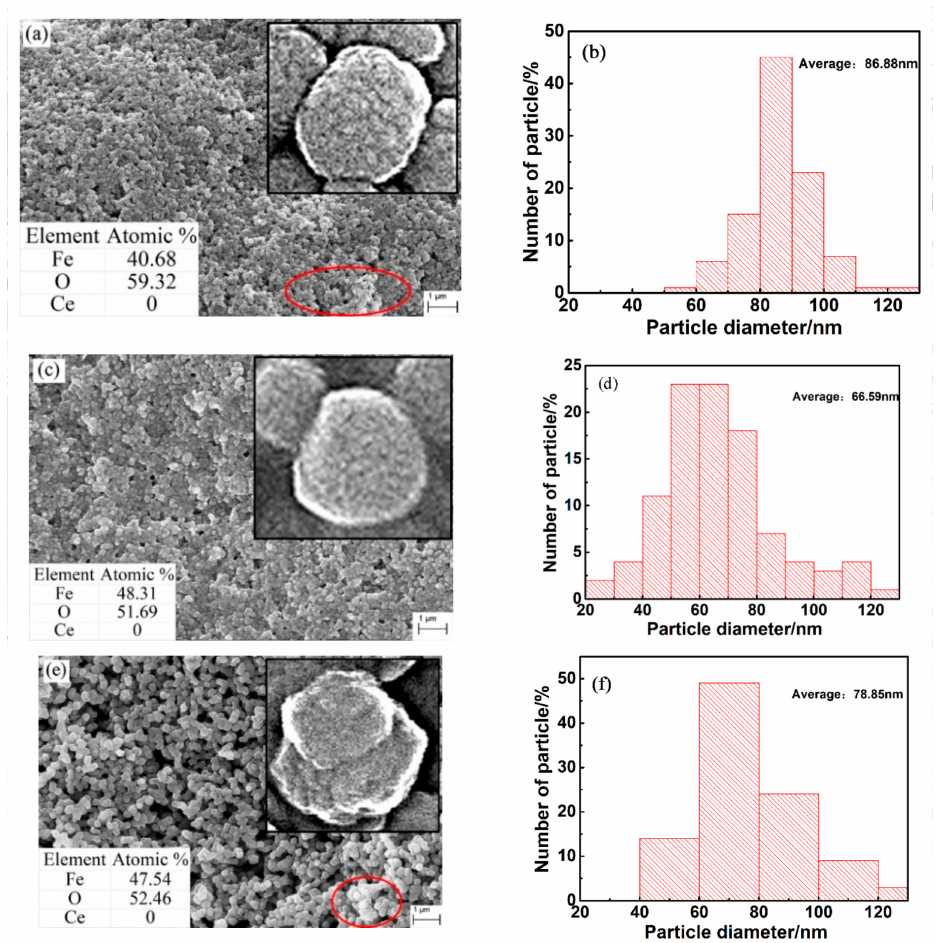
Figure 3. SEM (scanning electron microscopy) images and size distribution histograms of samples. ( a , b ) Undoped α -Fe 2 O 3 sample; ( c,d ) Ce-doped α -Fe 2 O 3 sample; ( e,f ) Bayer α -Fe 2 O 3